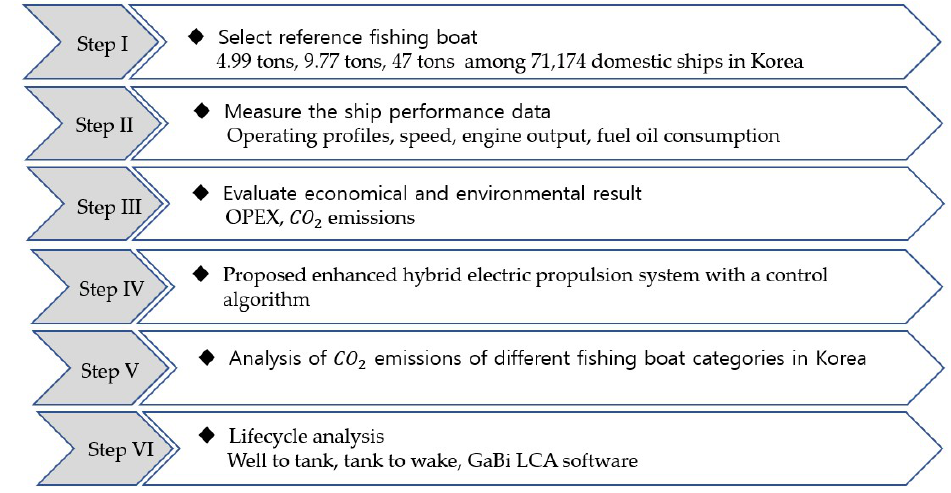
Figure 2. Domestic ships and fishing boats in Korea: ( a ) number of domestic cargo ships and fish- ing boats; ( b ) domestic fishing boats by weight in tons.